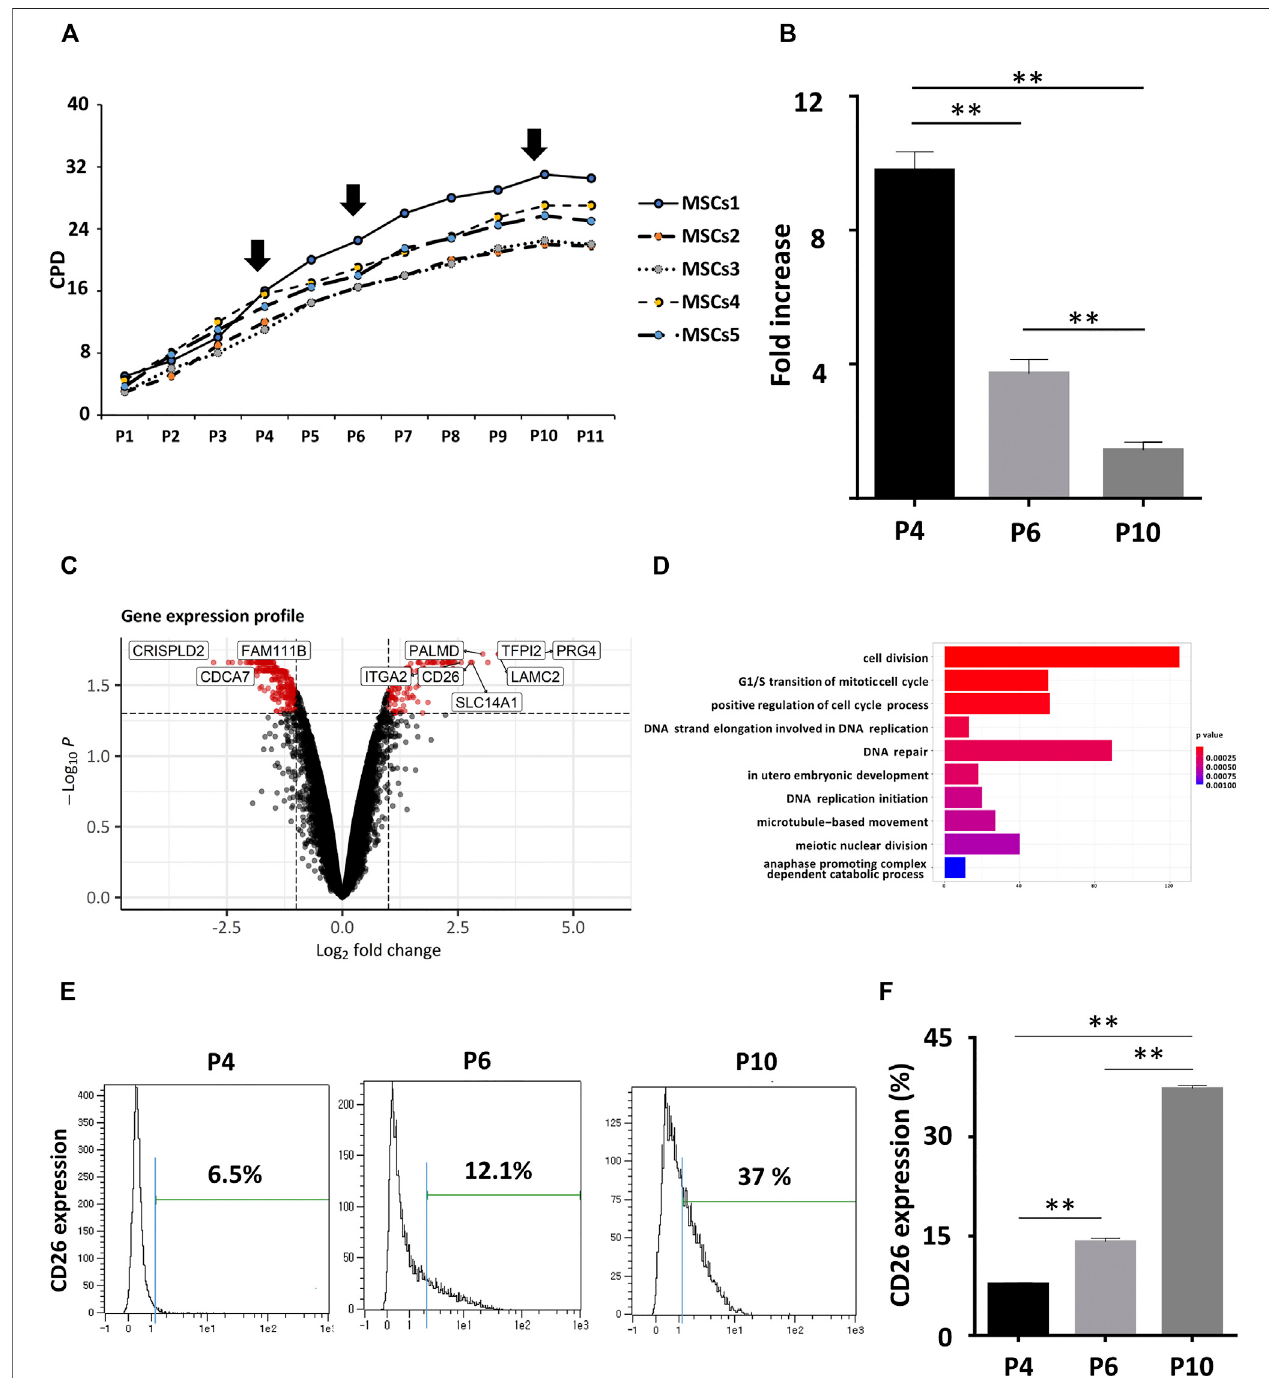
FIGURE1| CD26geneupregulationinaginghUCB-MSCs. (A) CPDsofhUCB-MSCsfrom fi vedifferentdonors. (B) FoldincreaseofhUCB-MSCsateachpassage ( n (cid:1) 3).Thefoldincreasewascalculatedbydividingthenumberofharvestedcellsbythenumberofseededcells. (C) VolcanoplotshowingDEGsbetweenearly(passage 4) and late (passage 10) hUCB-MSCs. Genes with log2 fold change > 1 and adjusted p value < 0.05 are marked as red. (D) Bar graph of enriched GO terms from the DEGs in (C) . The X-axisrepresents the number of genes included for each speci fi cGO terms. (E) CD26 expression in hUCB-MSCs at each passagemeasured by fl ow cytometry. An isotype control was used to determine the threshold level (blue line). (F) Bar graph showing ratio of CD26 expressing cells in (D) ( n (cid:1) 3). Abbreviation: hUCB-MSCs, human umbilical cord-derived blood mesenchymal stem cells; CPD, cumulative population doubling; DEG, differentially expressed gene; GO, gene